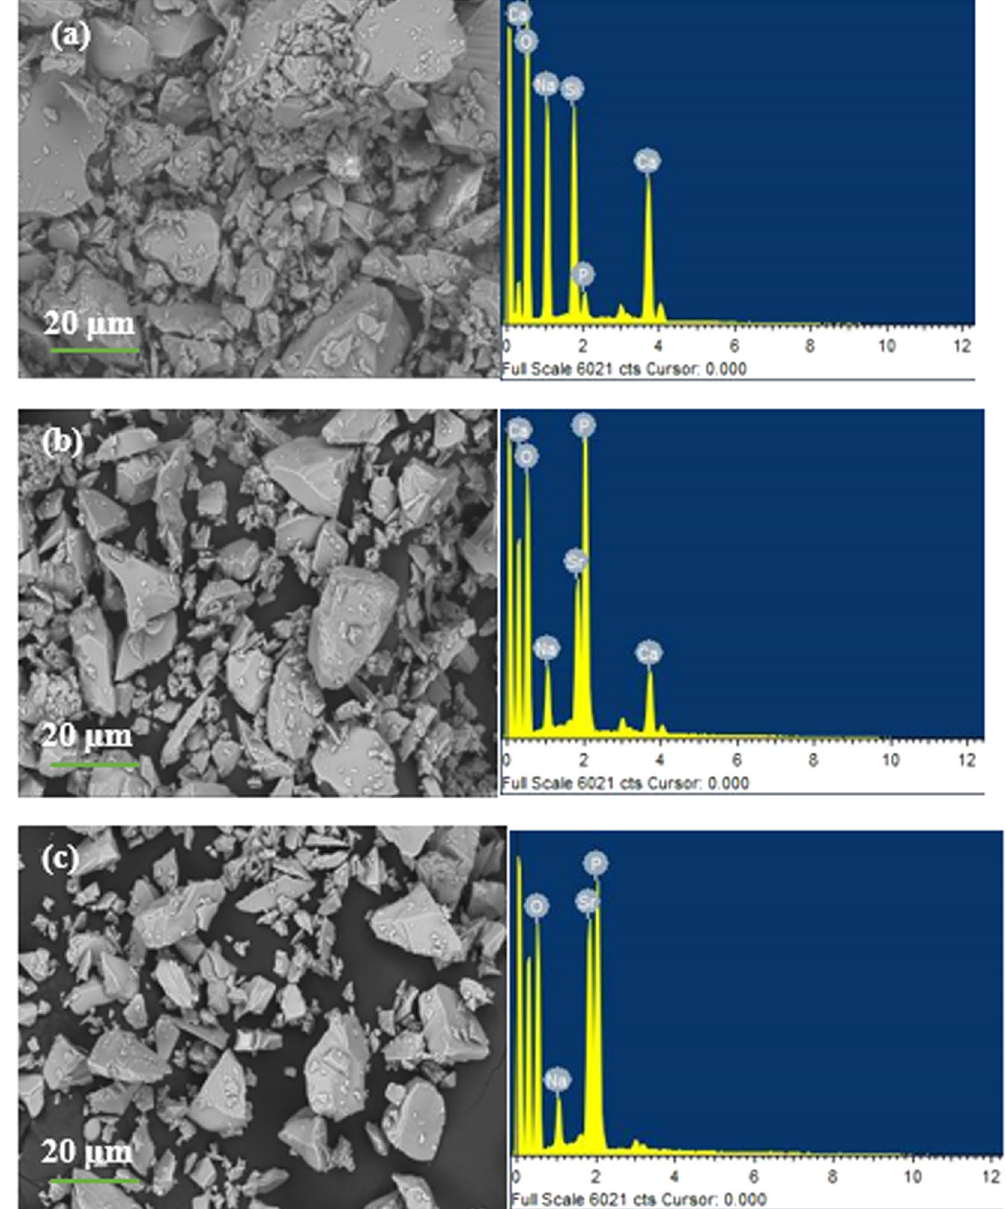
Figure 3. SEM images of ( a ) S53B50 ( b ) P40B10 and ( c ) Sr bioactive glass powder showing the particle size, shape and EDS